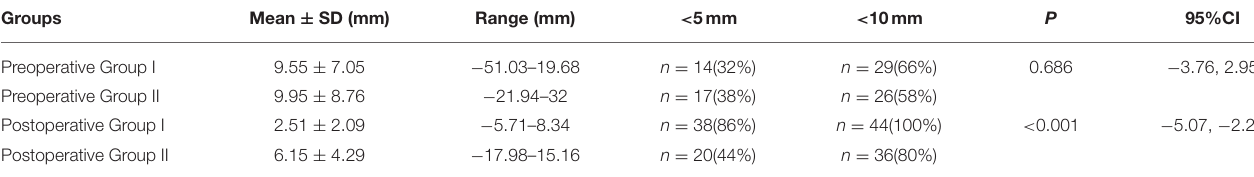
TABLE 2 | Comparison of radiographic LLD.